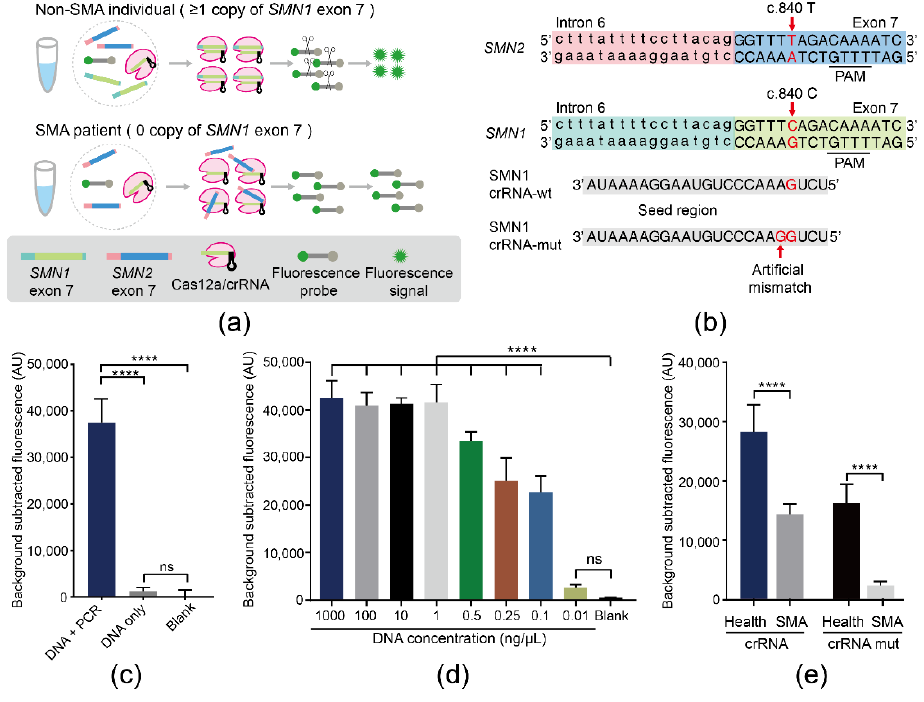
Figure 1. The SMA-Cas12a assay with a fluorescence probe. ( a ) In non-SMA individuals, SMN1 exon 7 triggered Cas12a after being recognized by the Cas12a/crRNA complex. Activated Cas12a acquired collateral cleavage activity to nonspecifically degrade the vicinal fluorescence probe yielding fluorescence. However, SMA patients had no SMN1 exon 7 to activate Cas12a and could not generate fluorescence. ( b ) Design of SMN1 crRNA-wt and SMN1 crRNA-mut. ( c ) Results of comparing the magnitude of fluorescence in three groups: DNA amplified by PCR, DNA without amplification, and the blank control. Data are means ± SD, (**** p < 0.0001, ns, p > 0.05). ( d ) The minimum detectable concentration of genomic DNA of the SMA-Cas12a assay with a fluorescence probe. Data are means ± SD, (**** p < 0.0001, ns, p > 0.05). ( e ) Results from comparing SMN1 crRNA-wt with SMN1 crRNA-mut in the capacity of discriminating SMA patients and normal individuals. Data are means ± SD, (**** p < 0.0001).